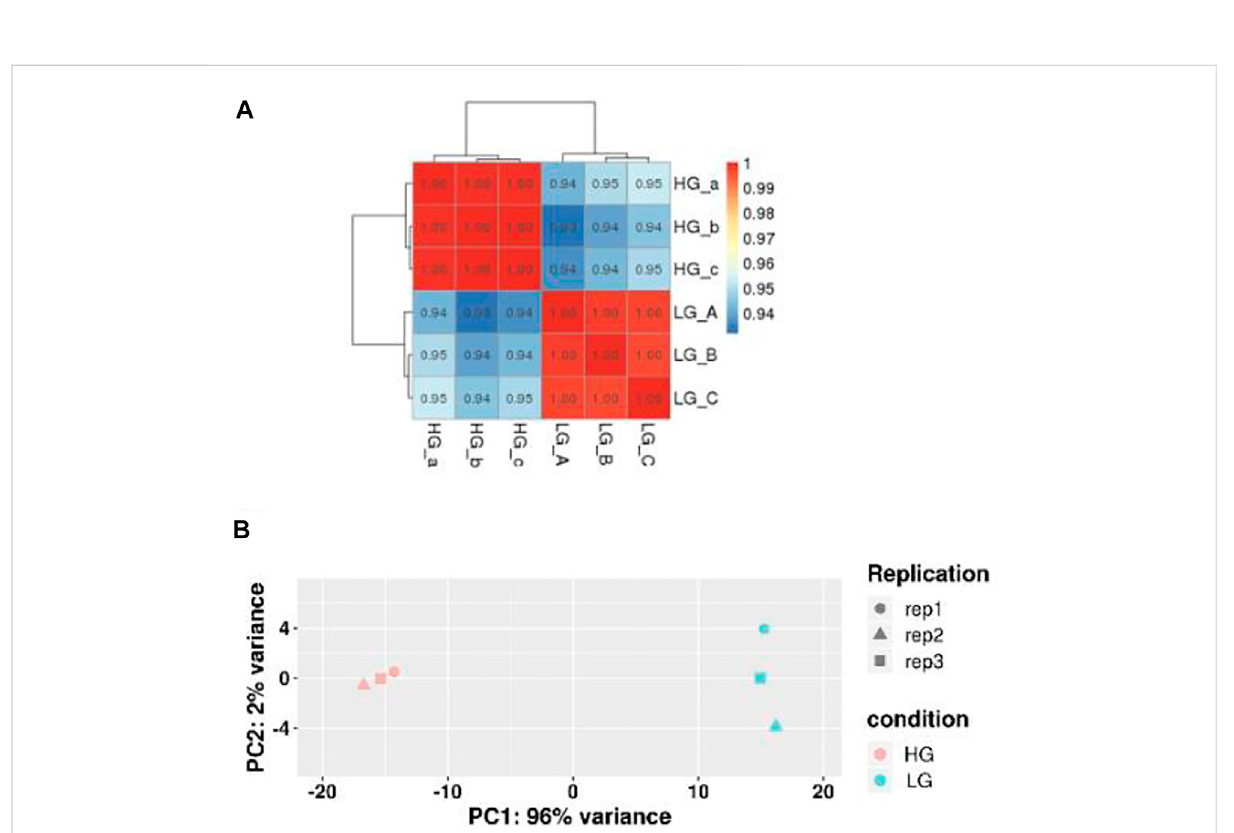
FIGURE 2 Correlationofgeneexpressionlevelsbetweensamples. (A) SampleCorrelationTest.Thecloserthecorrelationcoef fi cientwastoone,themore similartheexpressionpatternsbetweensampleswere. (B)